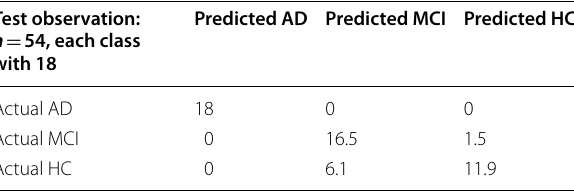
The results are obtained using the optimal feature engineering approach, i.e. the horizontal detail coefficients with Type-SD, from the gradiometer modality